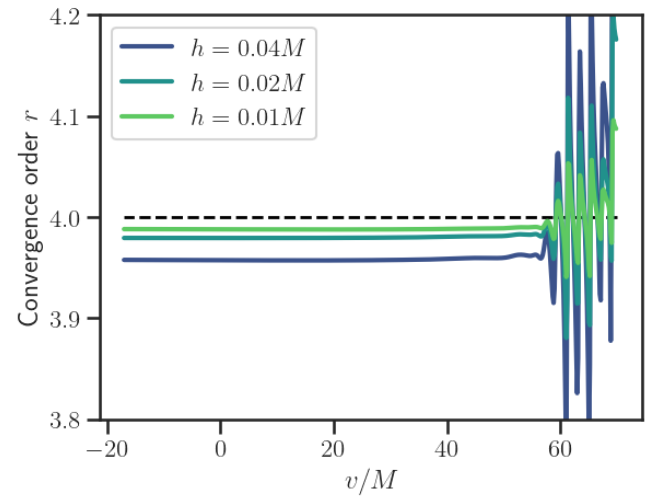
Figure 2 . Convergence order measured with h = 0 . 04 M, 0 . 02 M, 0 . 01 M and ‘ max = 6 with an additional 3 ghost modes. The result is consistent with the expected 4th-order